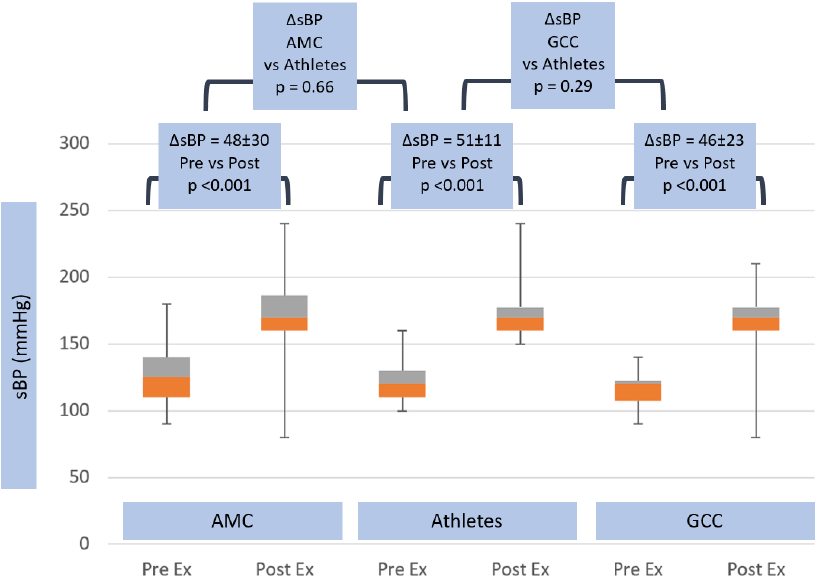
Figure 3. Systolic blood pressure response in age matched controls, athletes and general community cohort populations, pre- and post-exercise. The box and whisker plots depict the minimum, first quartile, median, third quartile and maximum values of each data set. The change in systolic blood pressure from pre- to post-exercise is shown for the three groups, with standard deviations and p -values. The change in systolic blood pressure between all groups is also shown, with p